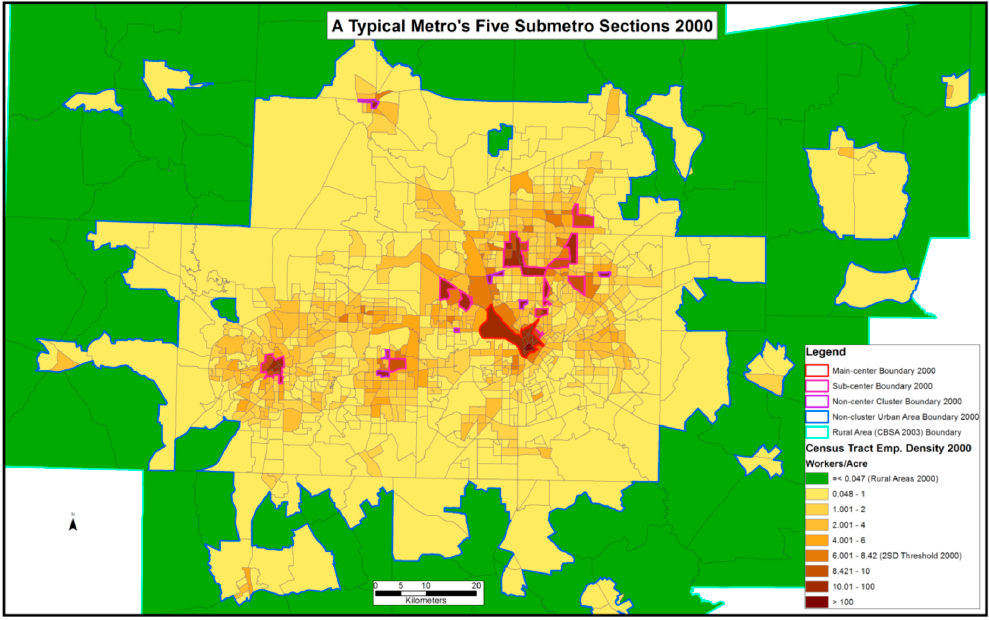
Figure 2. A typical metro’s (Dallas–Fort Worth–Arlington, TX) five submetro sections in 2000.